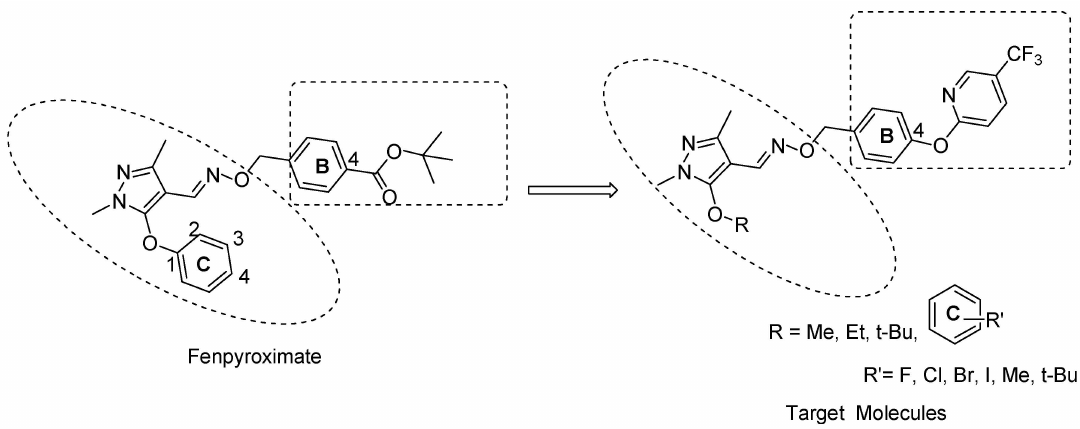
Figure 1. The design of the target